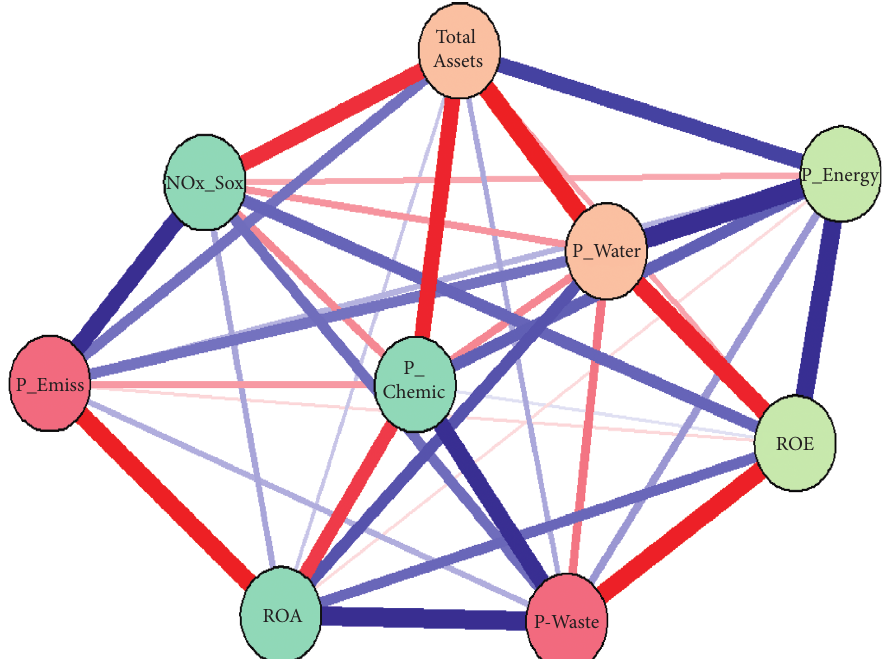
Figure 5: The association between policy measures and the financial performance (GGM), for the oil and gas companies from the EEA, 2009–2018. Source: own contribution in R